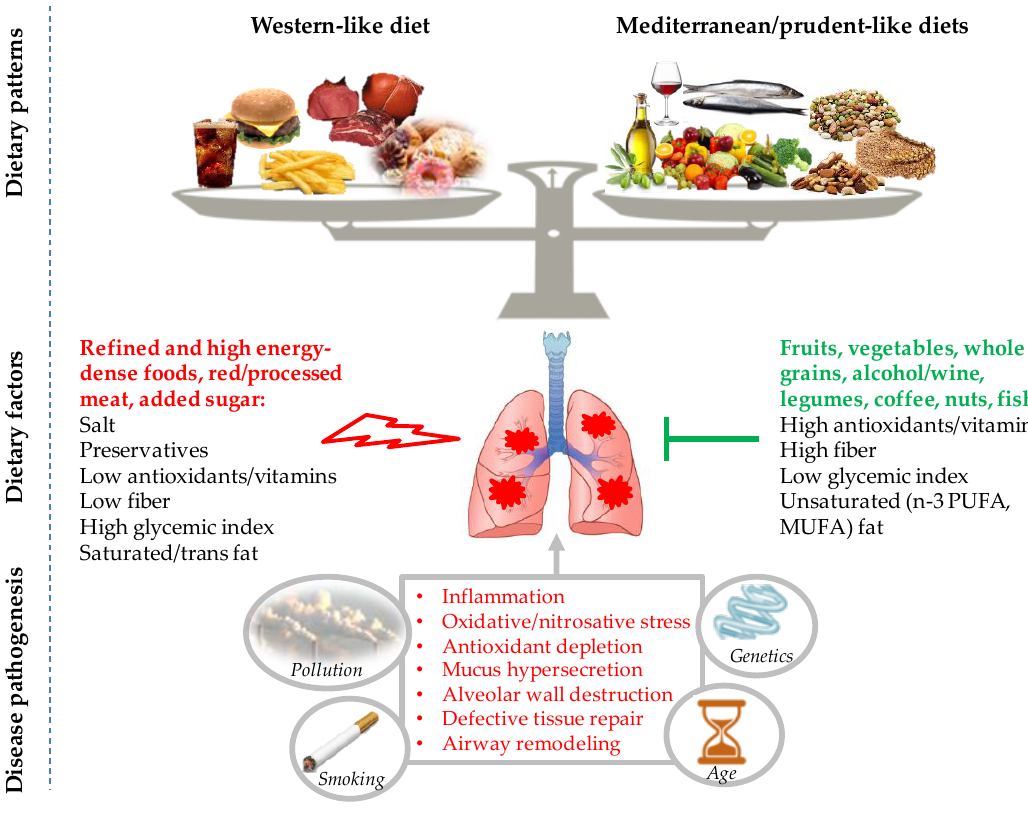
Figure 2. A framework model of the interactions of diets and dietary factors with lung function and COPD development and progression.